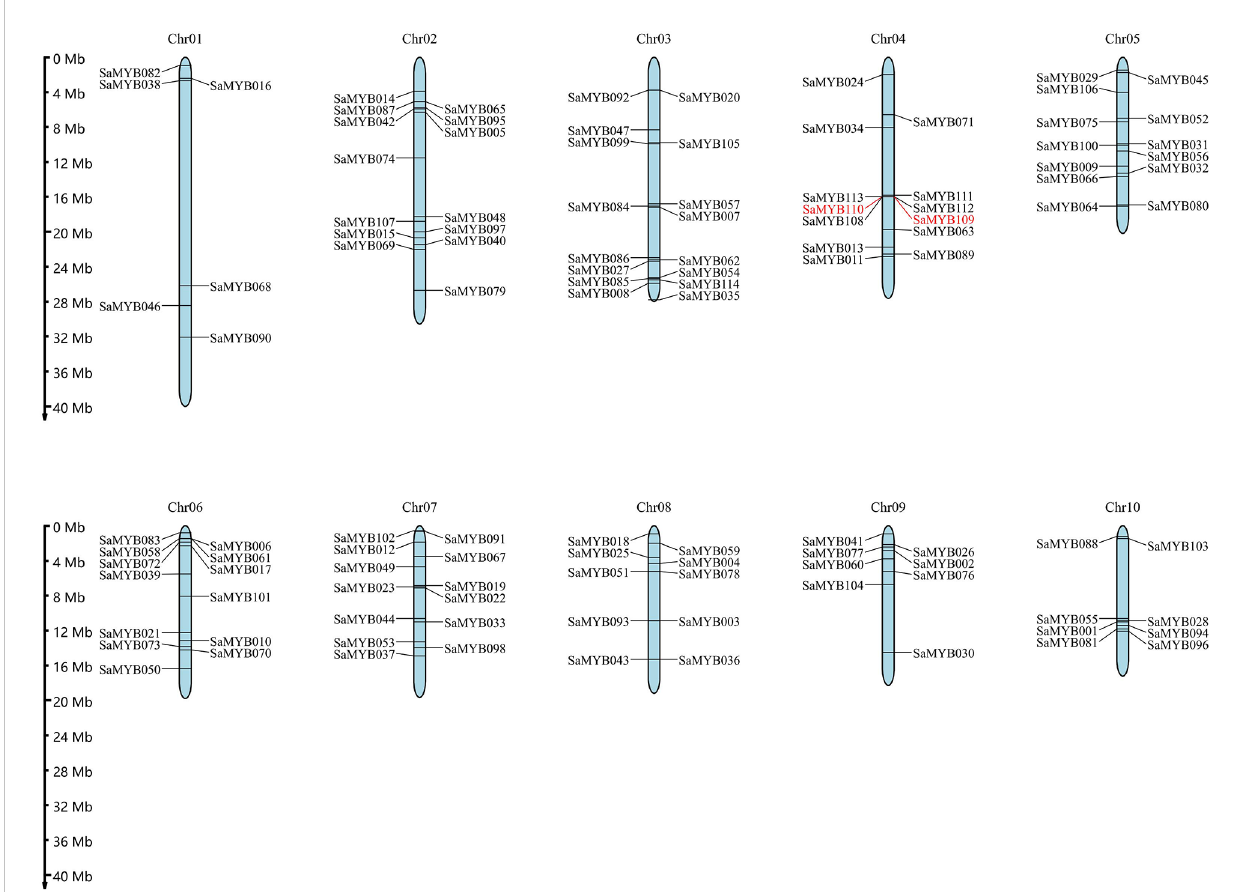
FIGURE 4 Chromosomal locations of the 114 R2R3-MYB genes in S. album . The ruler on the left indicates the physical position of reference genome. The pair of tandem duplicated genes is shown in red